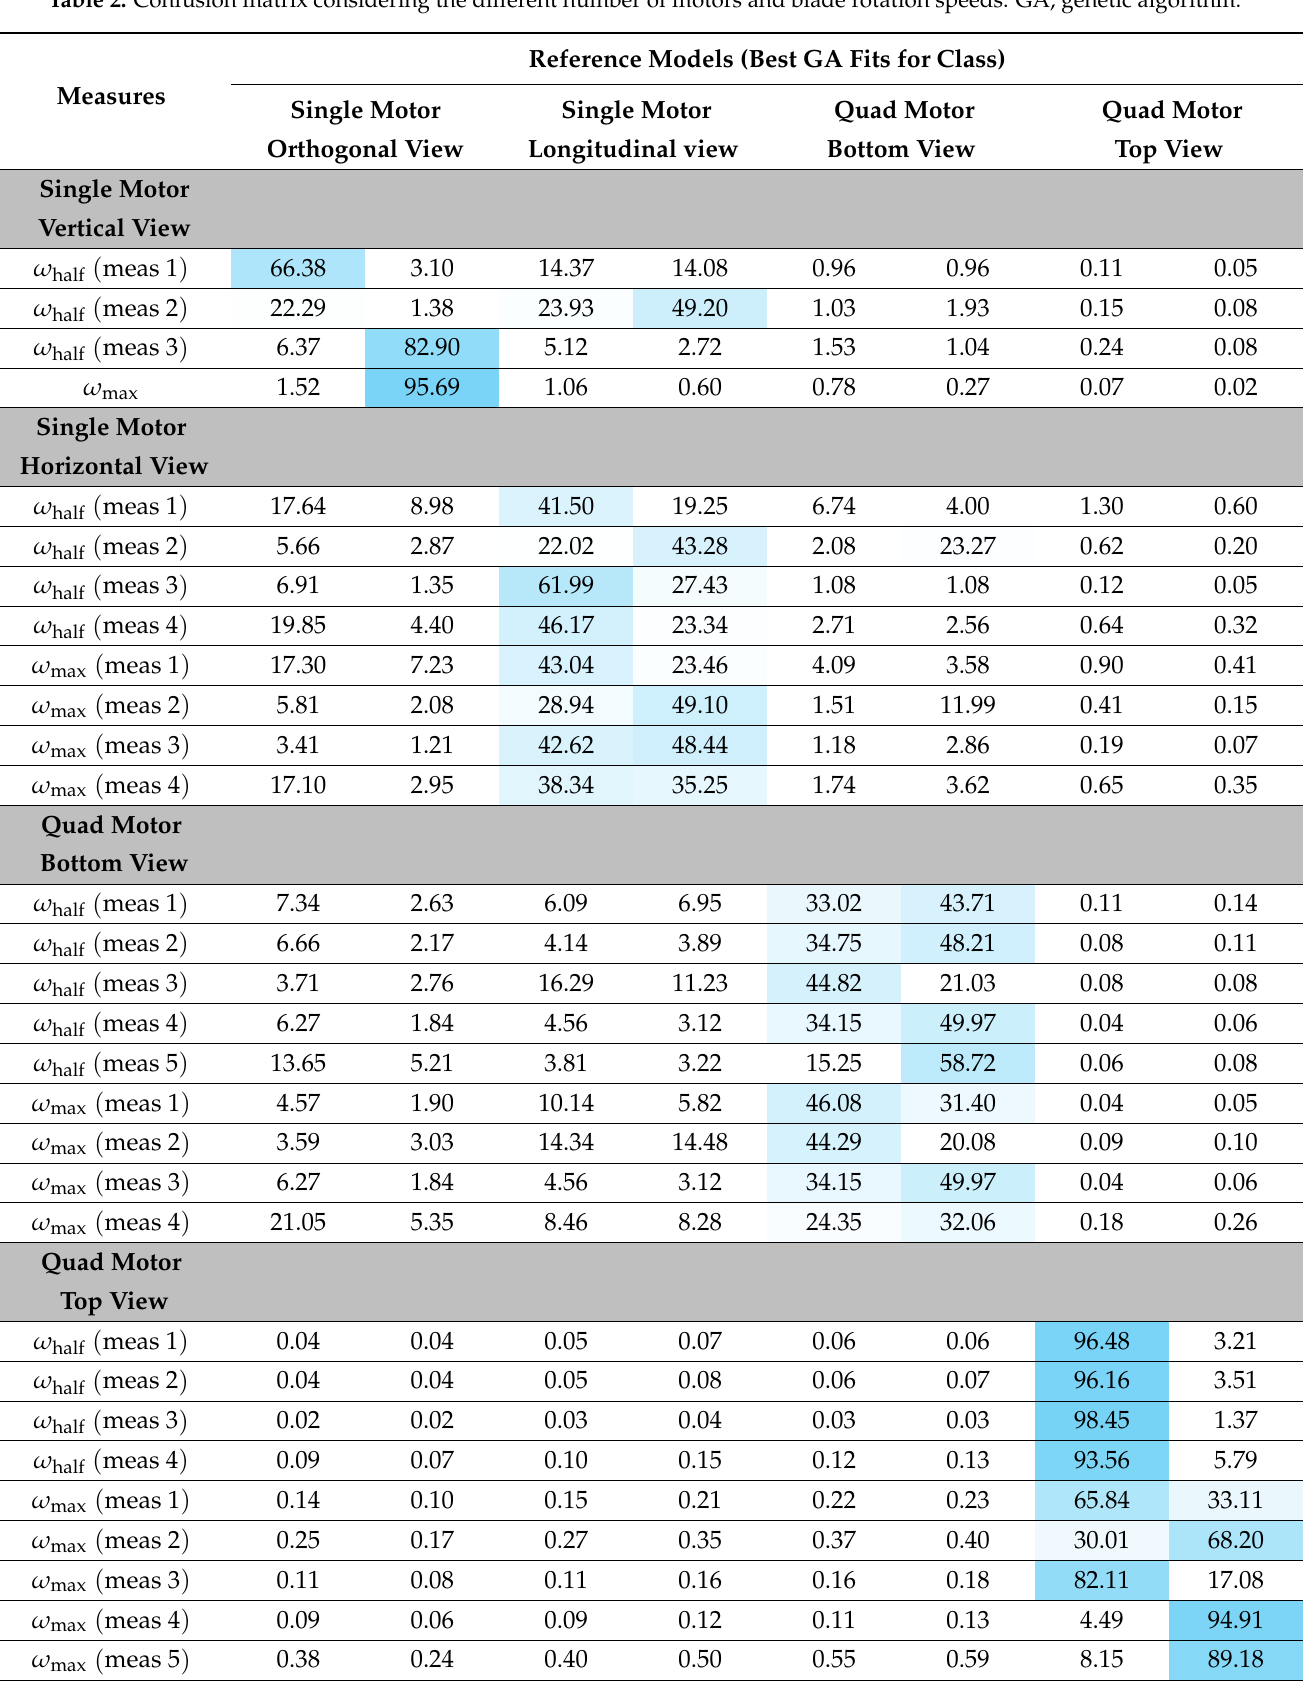
Table 2. Confusion matrix considering the different number of motors and blade rotation speeds. GA, genetic